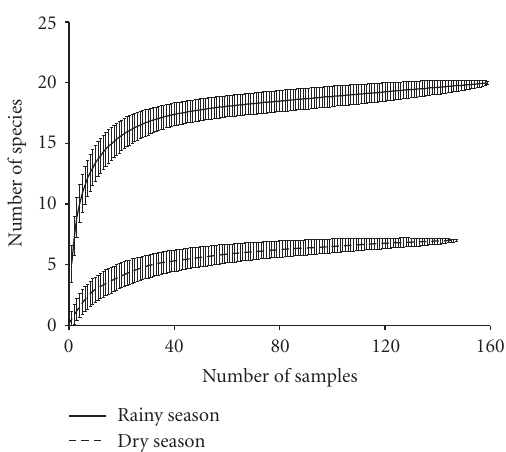
Figure 1: Absolute abundance of drosophilid species breeding in Mauritia flexuosa fruits in a gallery forest of the Ecological Reserve of IBGE, Bras ´ ılia, DF. wil: Drosophila willistoni , fum: D. fumipennis ,